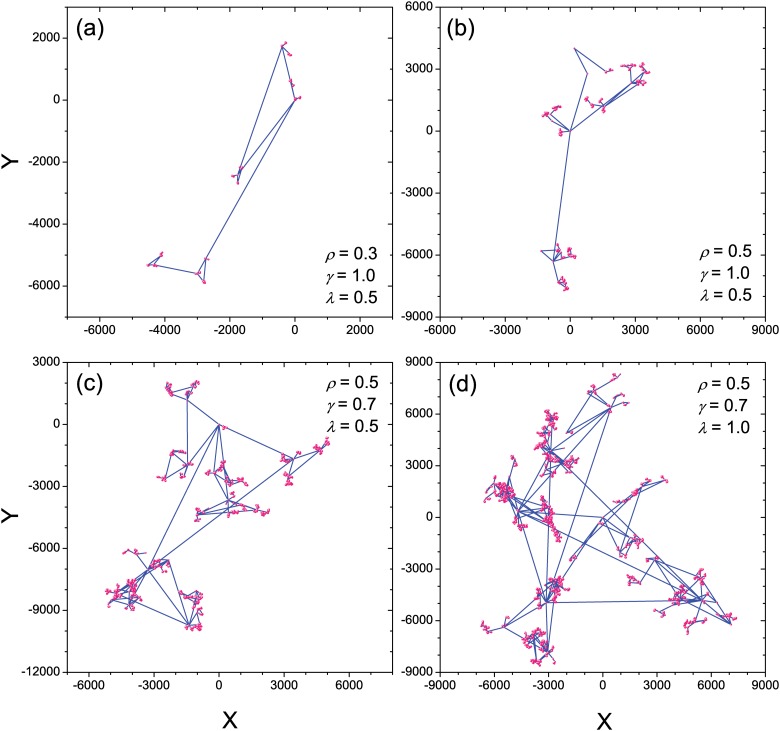
Typical trajectories of the model.Illustrations of the trajectories of 5 × 104 consecutive travels generated by the model with four typical parameter settings of ρ, γ and λ.